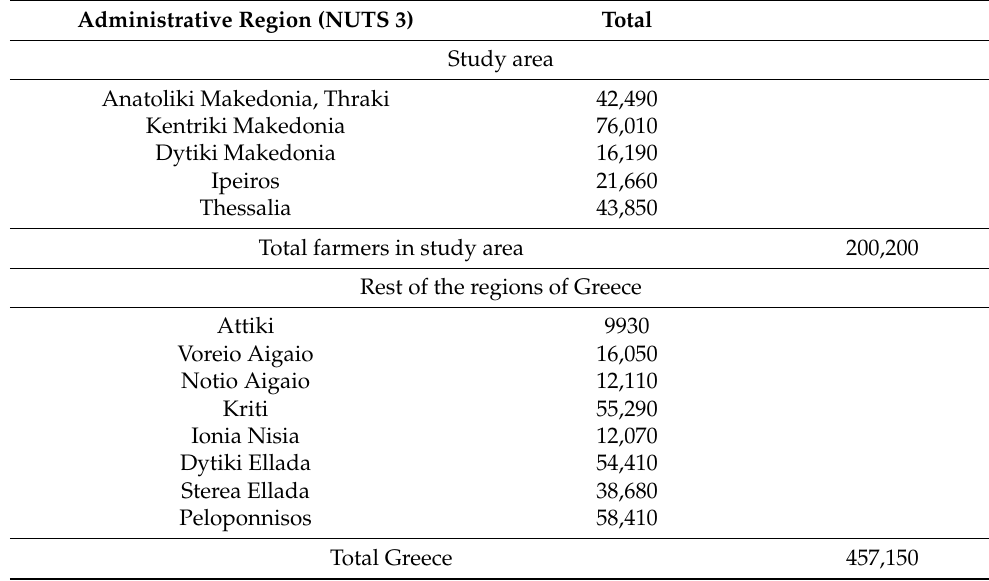
Table 2. Labor farmer force in annual working unit (AWUs). Administrative Region (NUTS